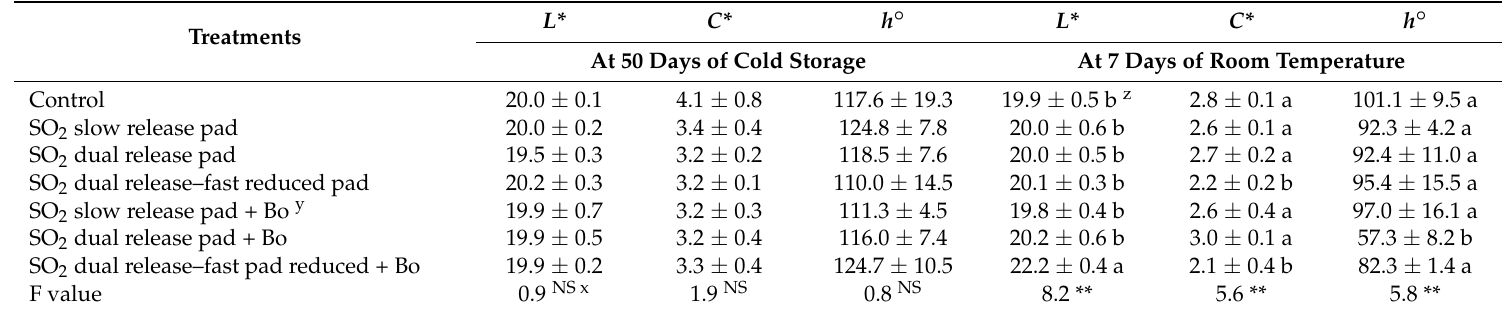
Table 4. Luminosity ( L* ), chroma ( C* ), and hue angle ( h ◦ ) of ‘BRS Vitoria’ seedless table grape at 50 days of cold storage and 7 days of room temperature under different SO 2 pad treatments.